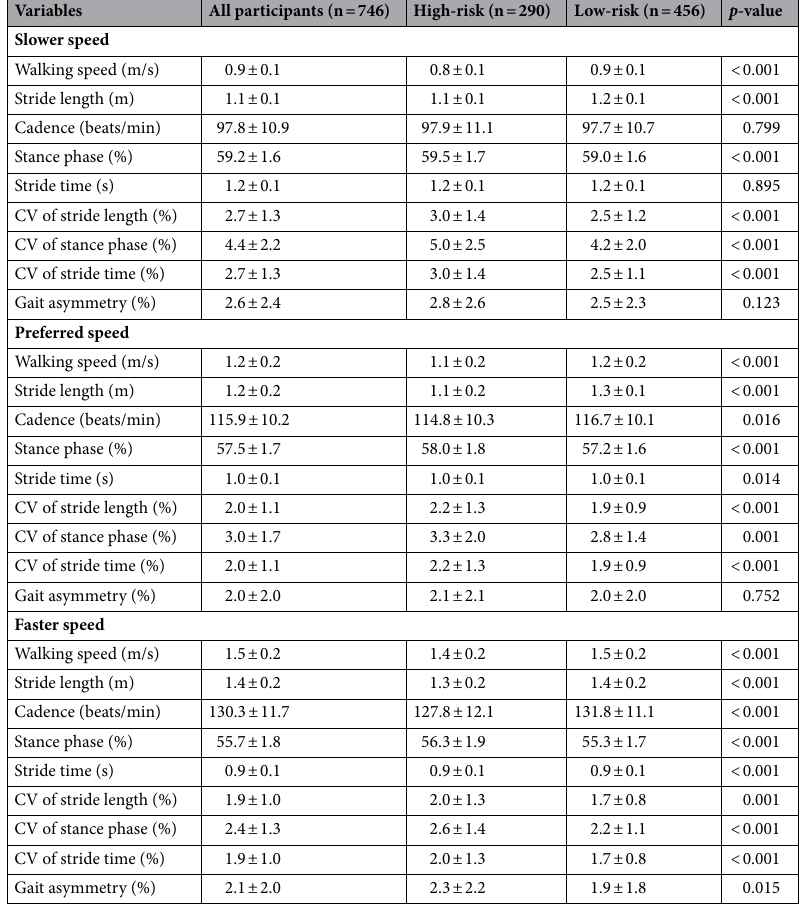
Table 2. Gait characteristics of participants. Mean ± SD mean and standard deviation, CV coefficient of variance, a significant difference between high- and low-risk of falls: p < 0.05.